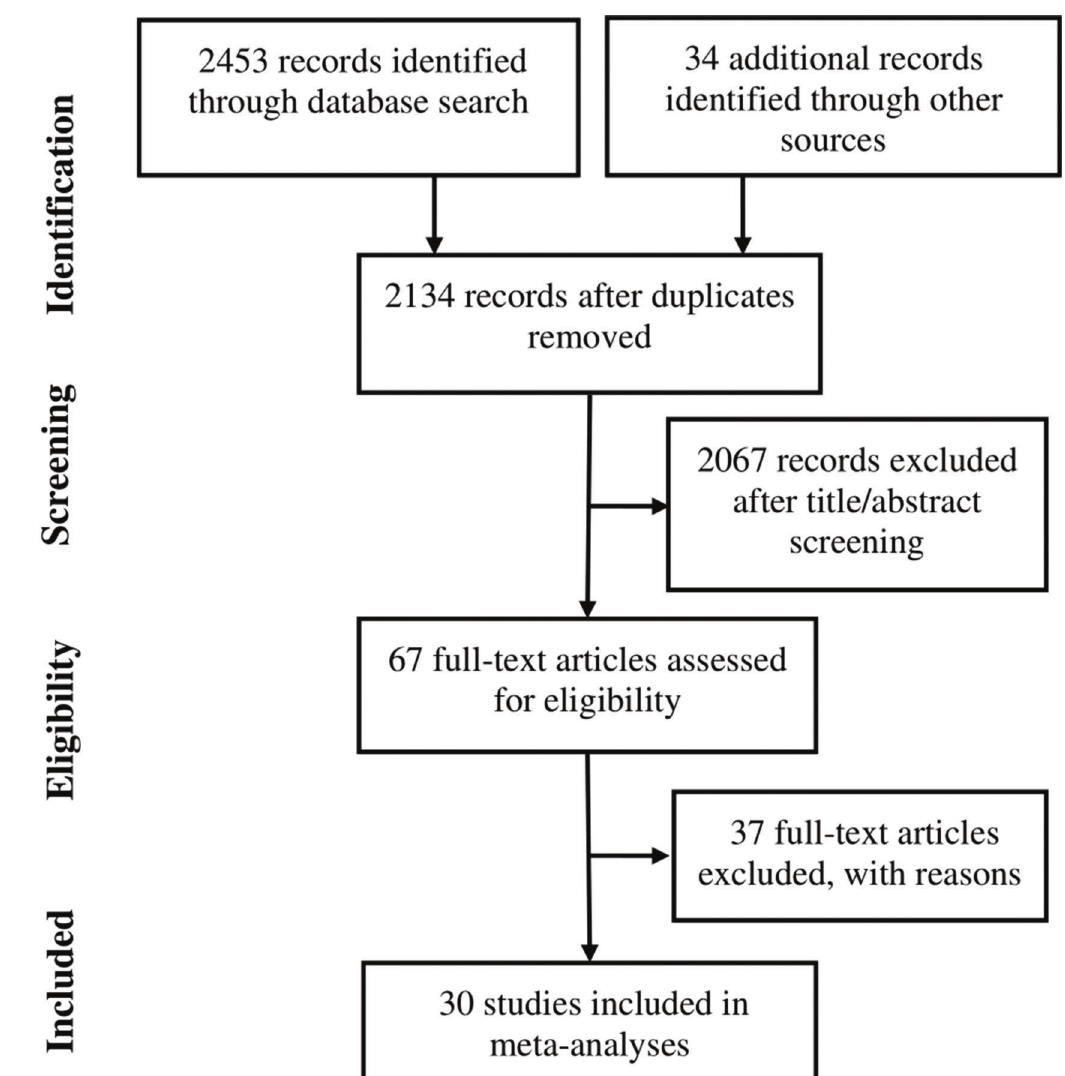
Figure S1 - Flowchart of the screening and selection of the included studies.